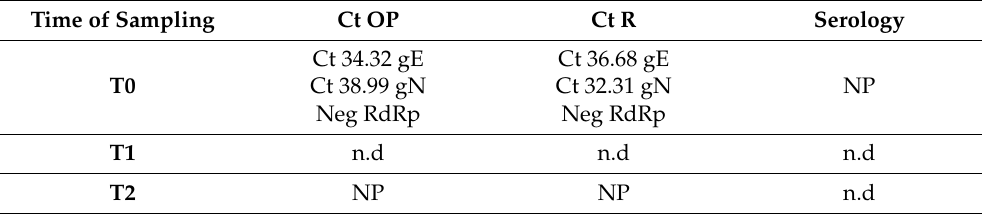
Table 4. Summary of the SARS-CoV-2 positive cat: timeline and laboratory results. Time of